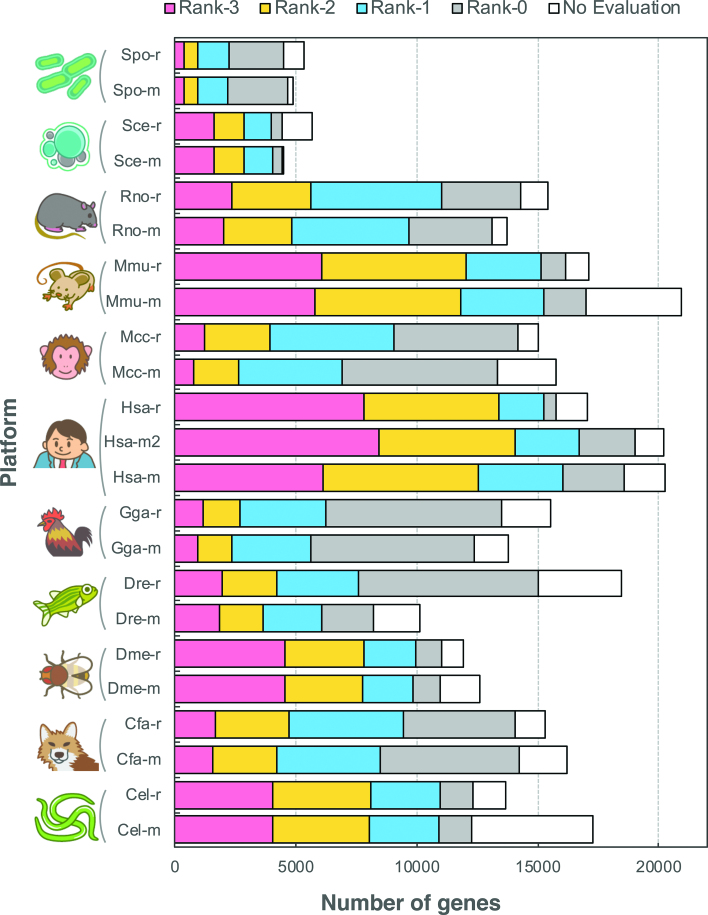
Proportion of supportability level of the coexpressed gene list for every guide gene. As a summarization metric of repeatability of the coexpressed gene list for a guide gene of interest, support was provided, which refers to the similarity of order of the top 1% of the coexpressed gene list with those of the orthologous guide genes. The similarity level is represented as the 4 quantile levels (rank-0 to rank-3) for simplicity.